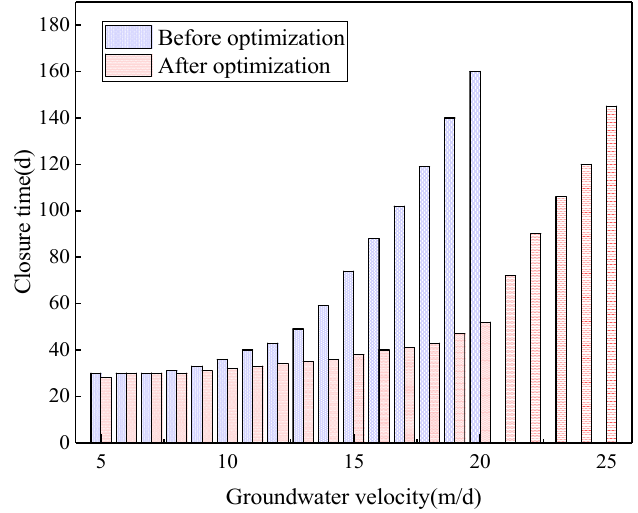
Figure 15. Comparison of frozen wall closure time before and after optimization.